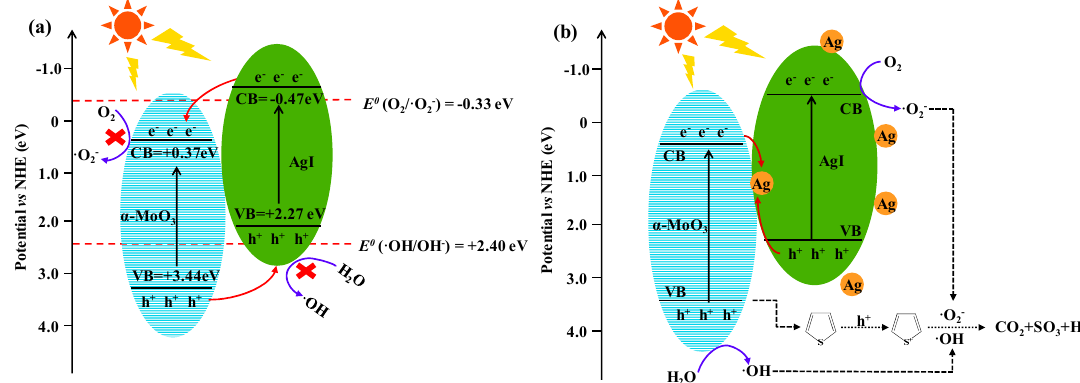
Scheme 2. Schematic illustration of photocatalytic oxidative desulfurization mechanism for thiophene by using catalysts ( a ) AgI/ α -MoO 3 and ( b ) Ag/AgI/ α -MoO 3